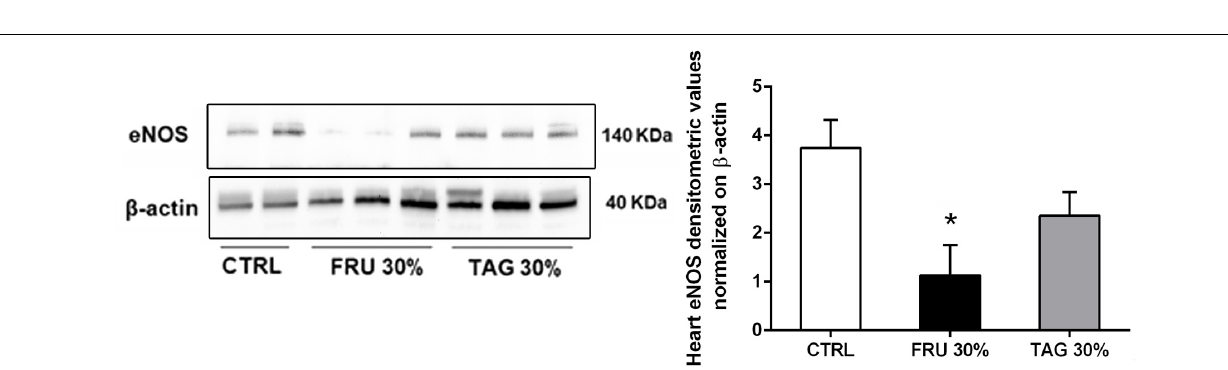
Frontiers in Molecular Biosciences |